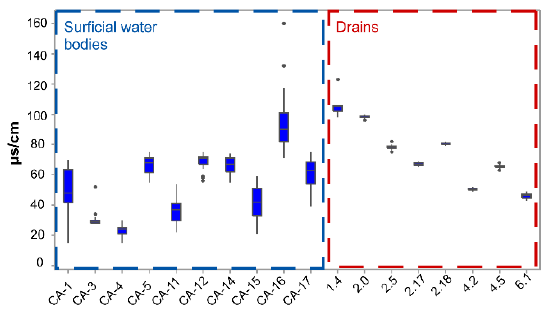
Figure 8. The electrical conductivity for 18 observation points in the slope for the period July – December/2018.